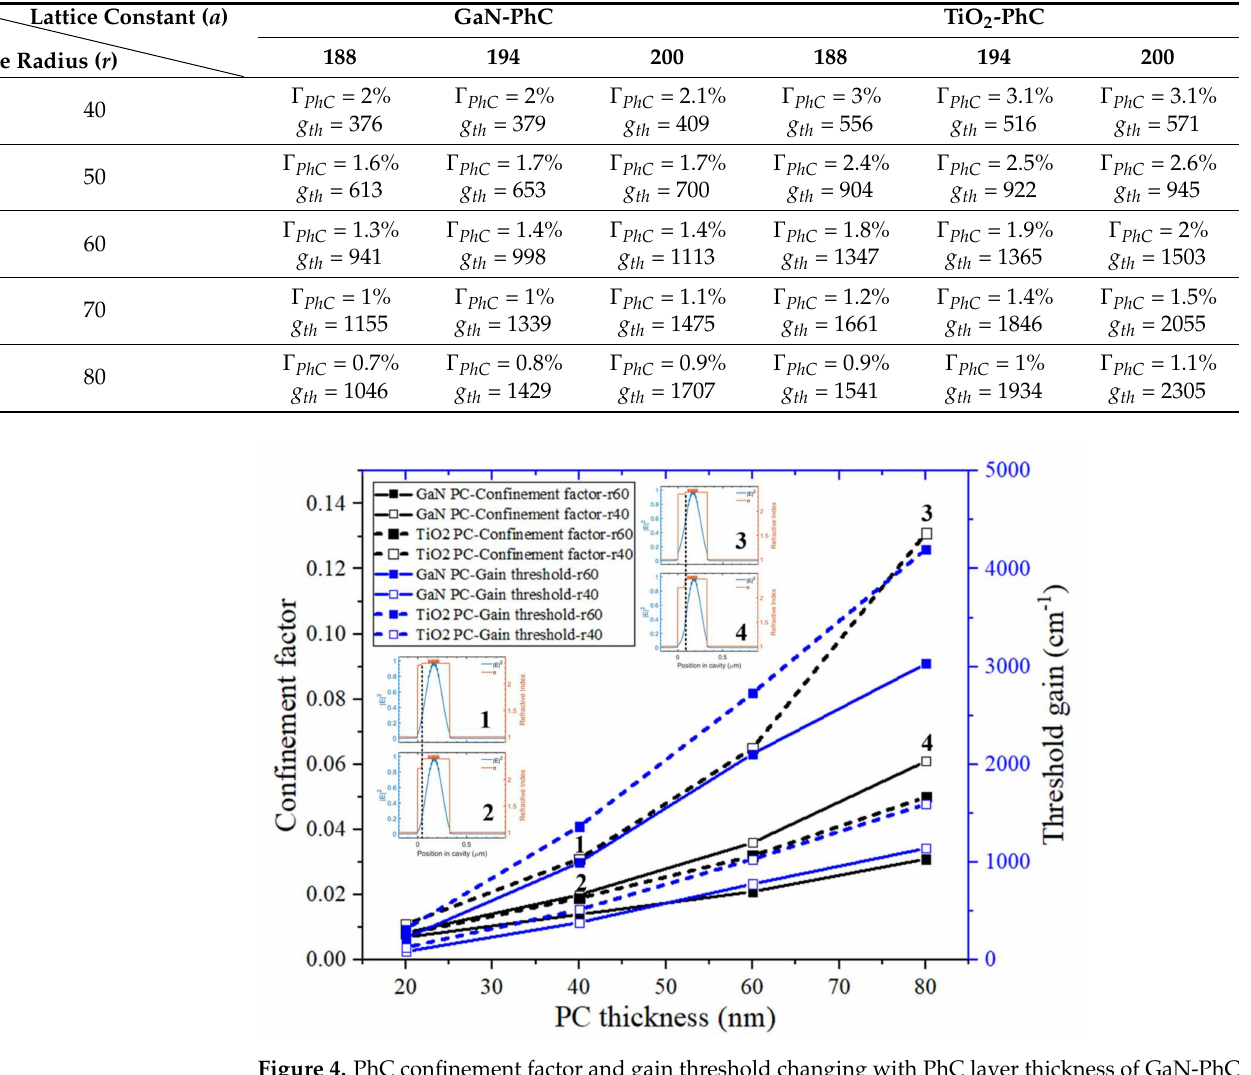
Figure 4. PhC confinement factor and gain threshold changing with PhC layer thickness of GaN-PhC and TiO 2 -PhC at hole radius of 40 nm and 60 nm, respectively. The insets exhibit mode distribution in layers at 40 nm hole radius with ( 1 ) 40 nm and ( 3 ) 80 nm TiO 2 -PhC hole depth and ( 2 ) 40 nm and ( 4 ) 80 nm GaN-PhC hole